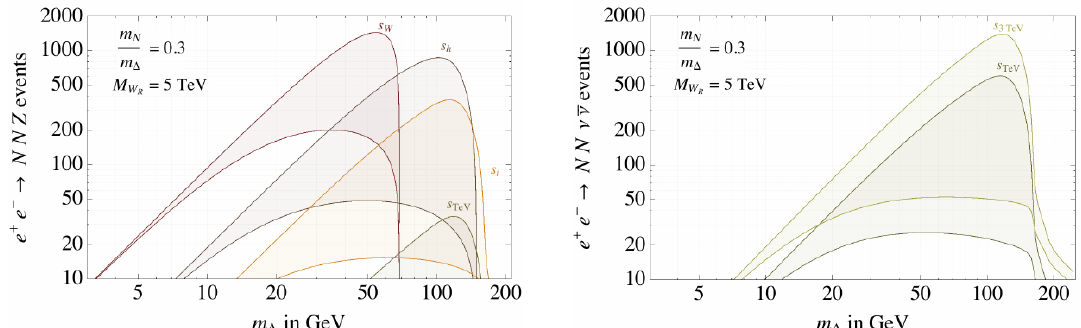
Figure 9 . Signal event rates for e + e (cid:0) ! NNZ and e + e (cid:0) ! NN(cid:23)(cid:23) productions at lepton colliders p for di(cid:11)erent s , universal luminosity of L = 1 ab (cid:0) 1 , m N = m (cid:1) = 3. The shaded regions cover the range s (cid:18) 2 (0 : 01 ; 0 :